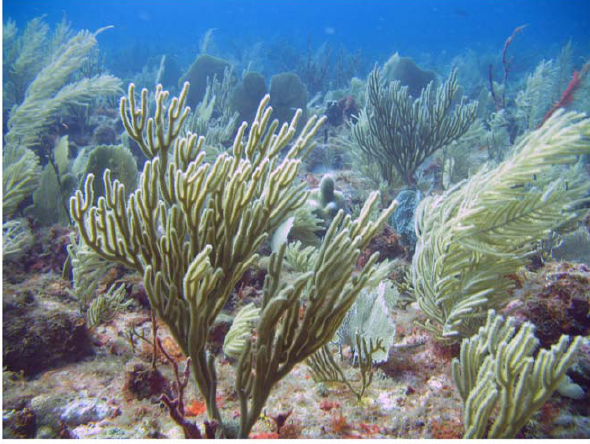
Figure 5. High-diversity gorgonian assemblage on the Saba Bank fore-reef. An image from one of the ‘‘A’’ sites on the fore-reef of Saba Bank ( , 25 m) shows an assemblage characterized by sea fans ( Gorgonia ventalina ), sea plumes ( Pseudopterogorgia americana ), and the Eunicea/Plexaura sp. complex, Eunicea fleuxosa , center. The fore-reef environment consists of a series of reef crests near the platform edge on Saba Bank [4] with diverse and abundant octocoral species.